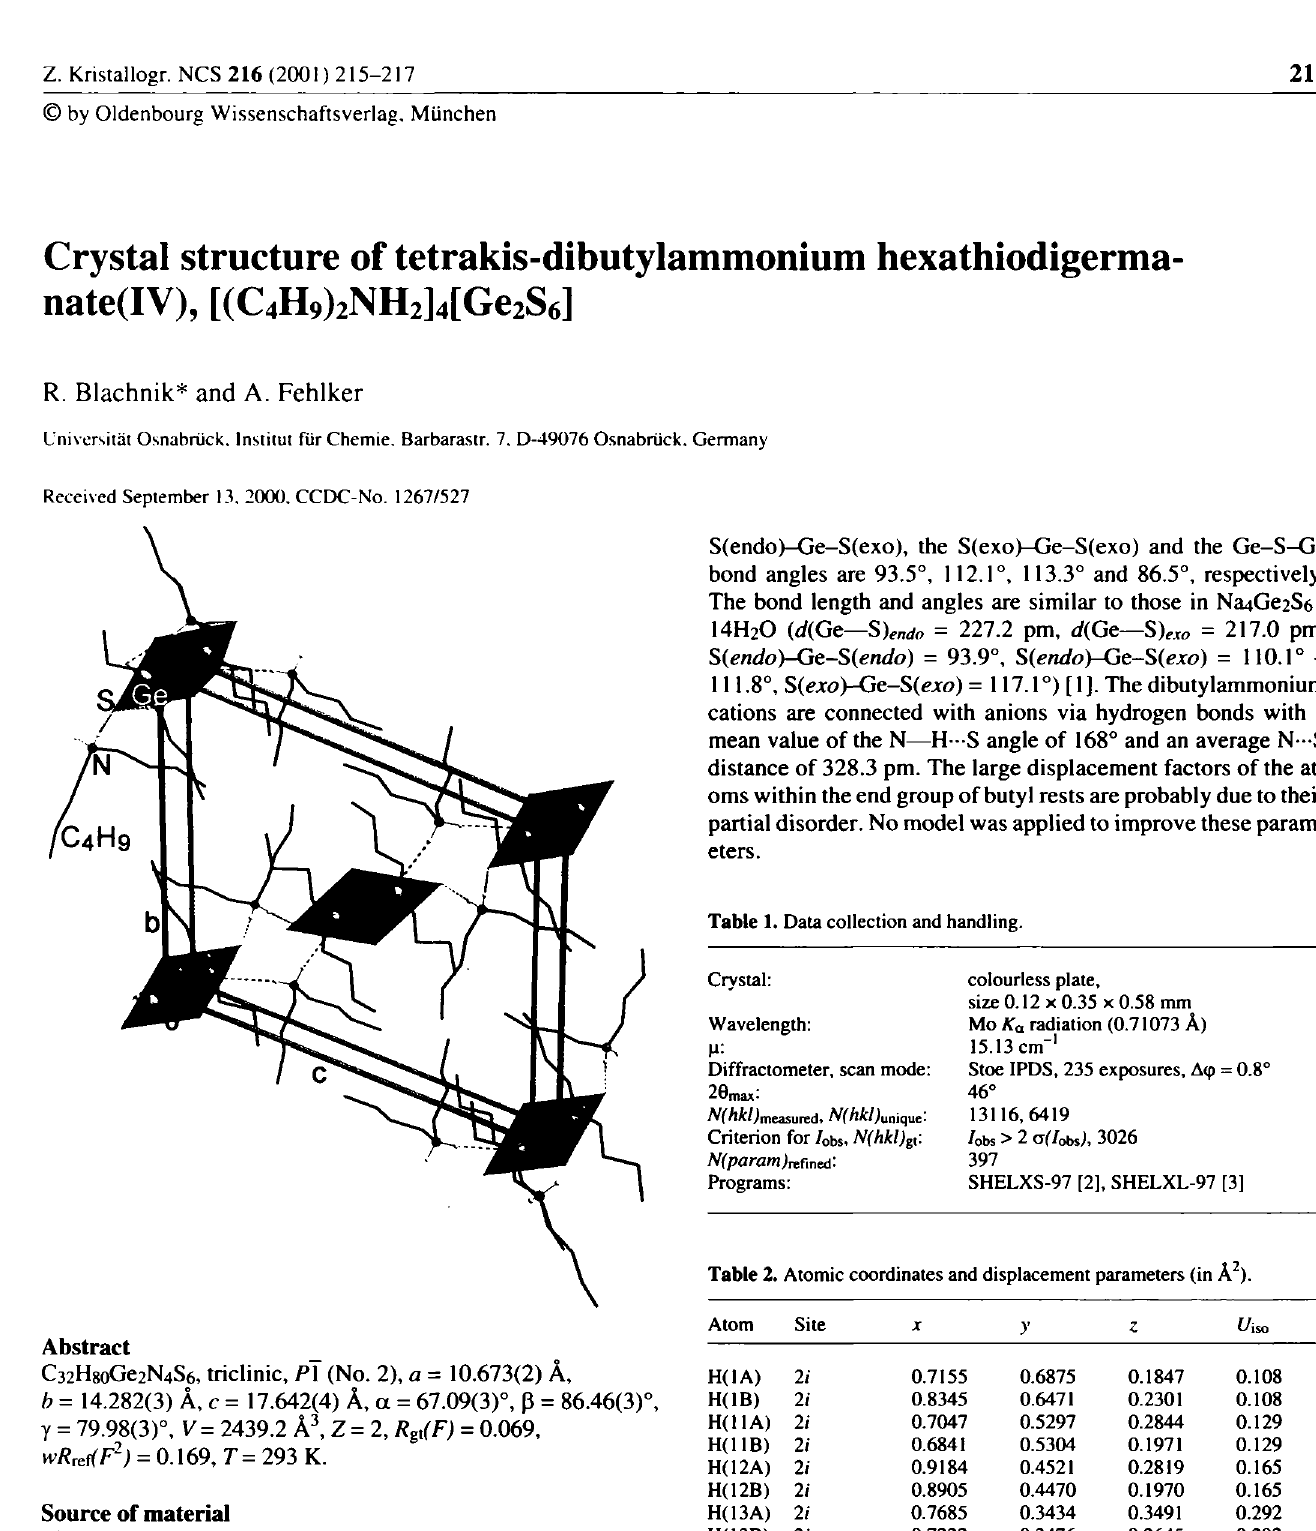
Table 2. Atomic coordinates and displacement parameters (in Ä 2